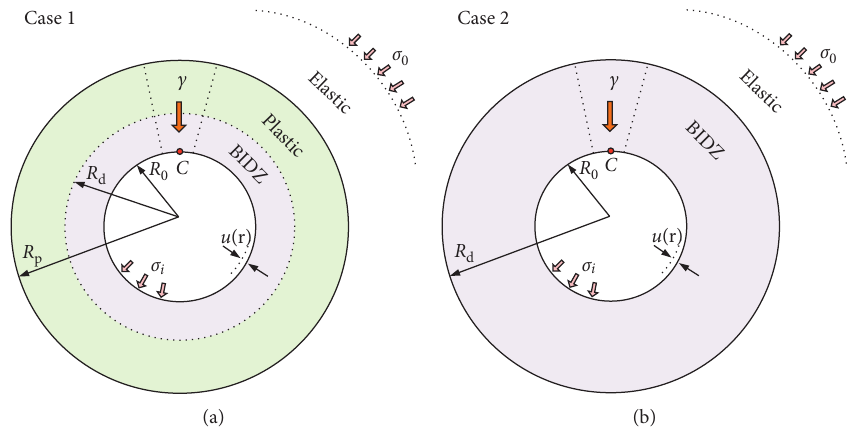
Figure 2: Deep tunnel subjected to a hydrostatic stress field with gravity effect and cylindrical BIDZ: (a) R